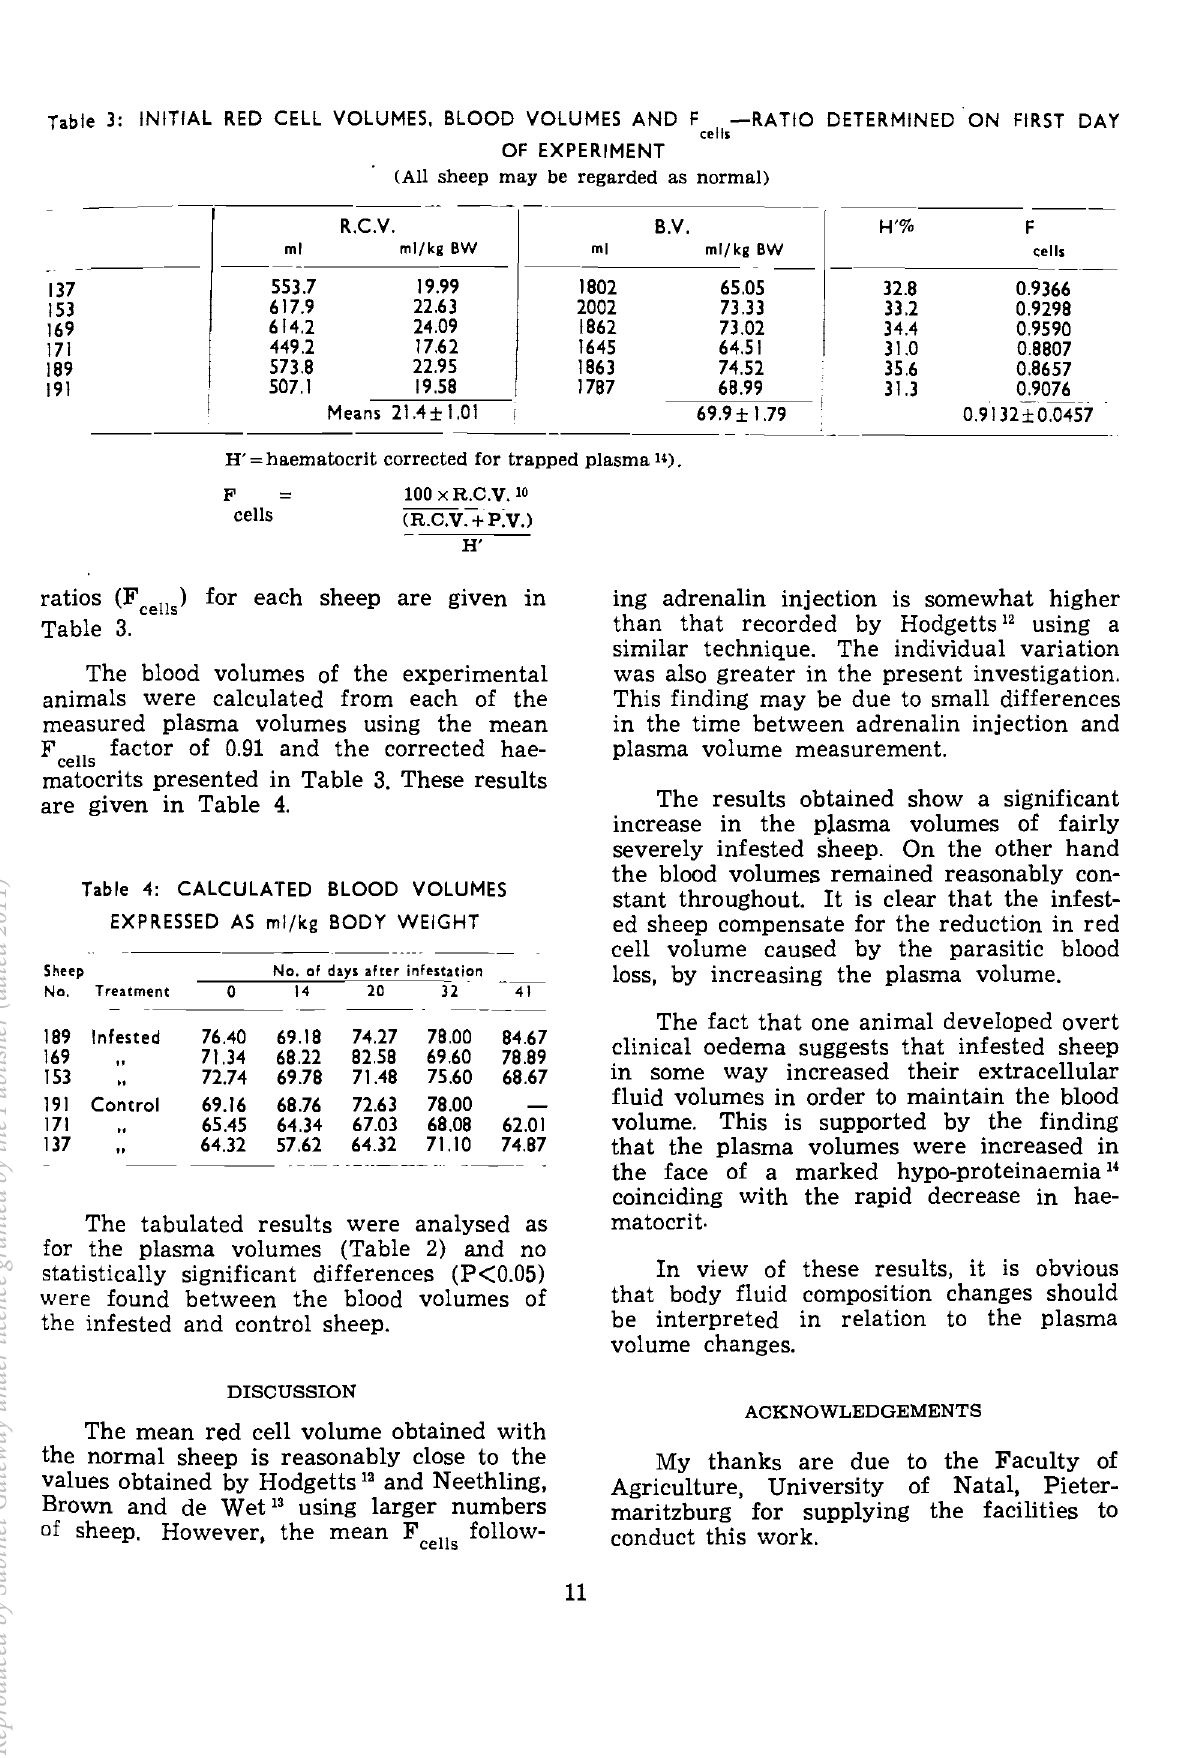
cells OF EXPERIMENT